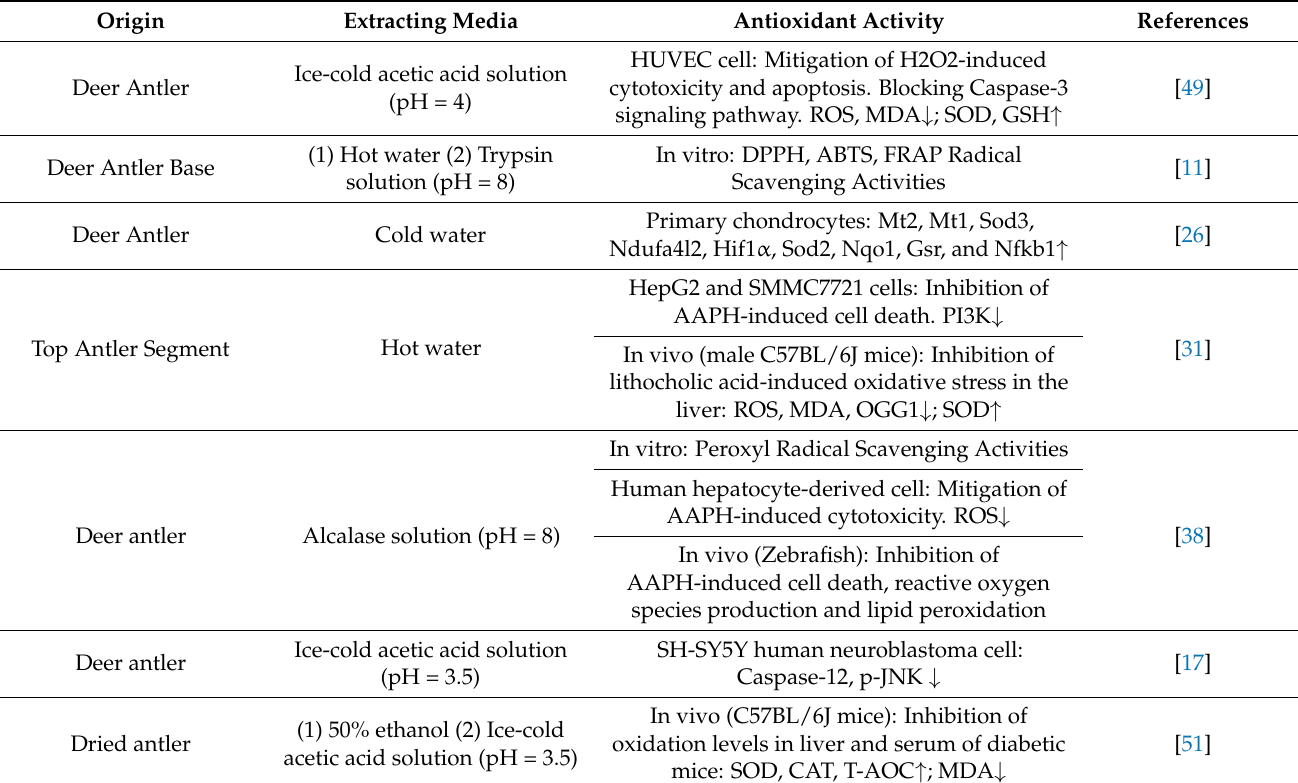
Table 3. Antioxidant activity of